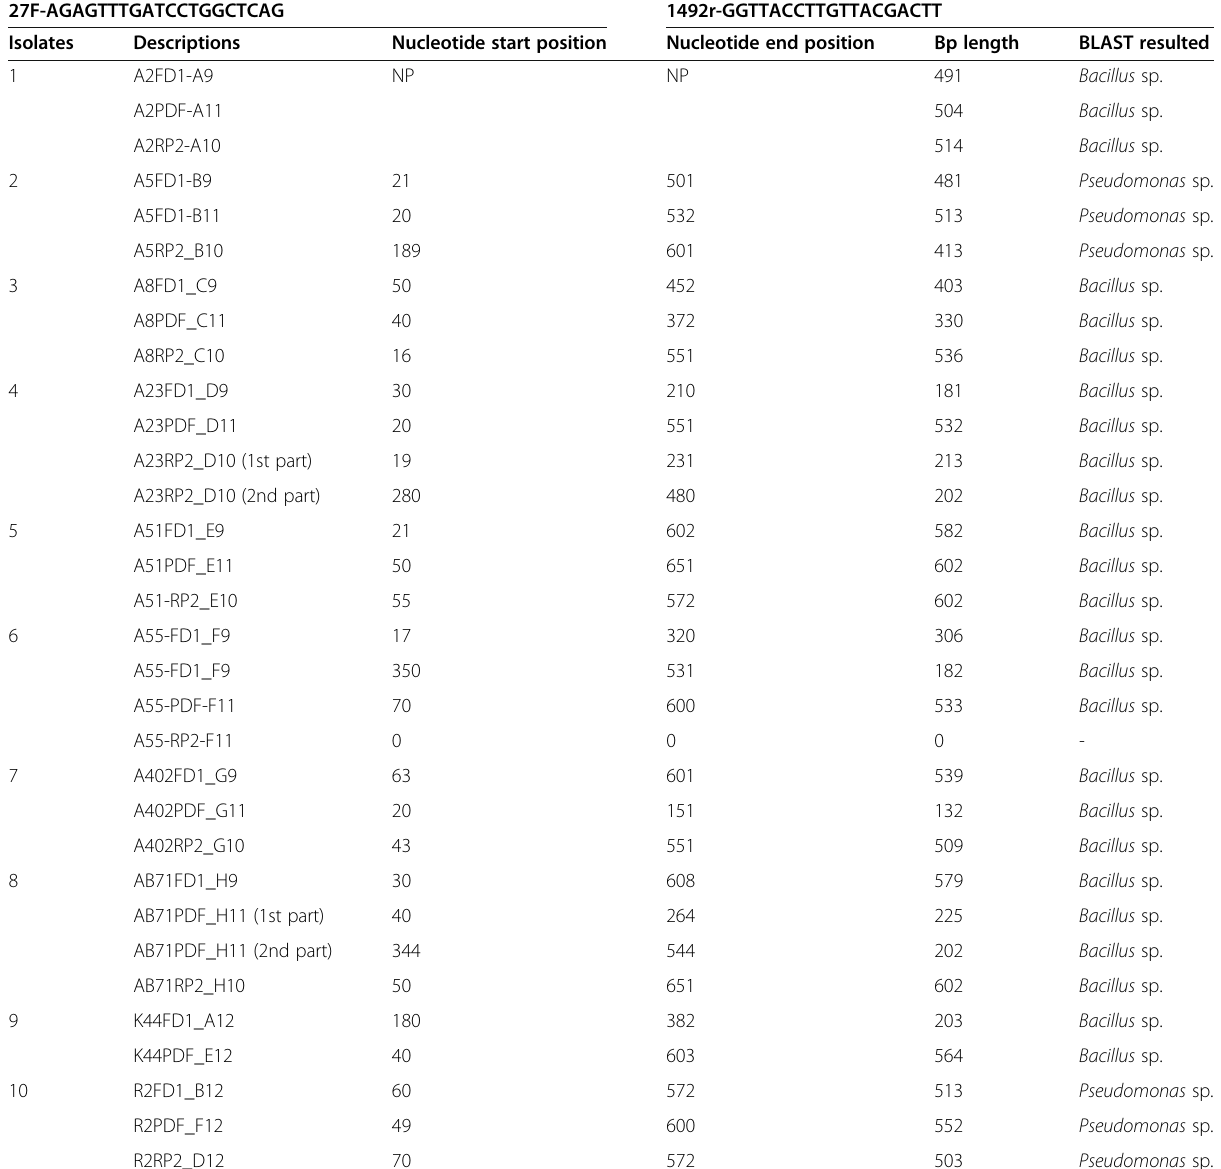
Table 4 Comparison of the sequences obtained from the amplifiates of the RNA16S gene extracted from the antagonist strains using BLAST 27F-AGAGTTTGATCCTGGCTCAG